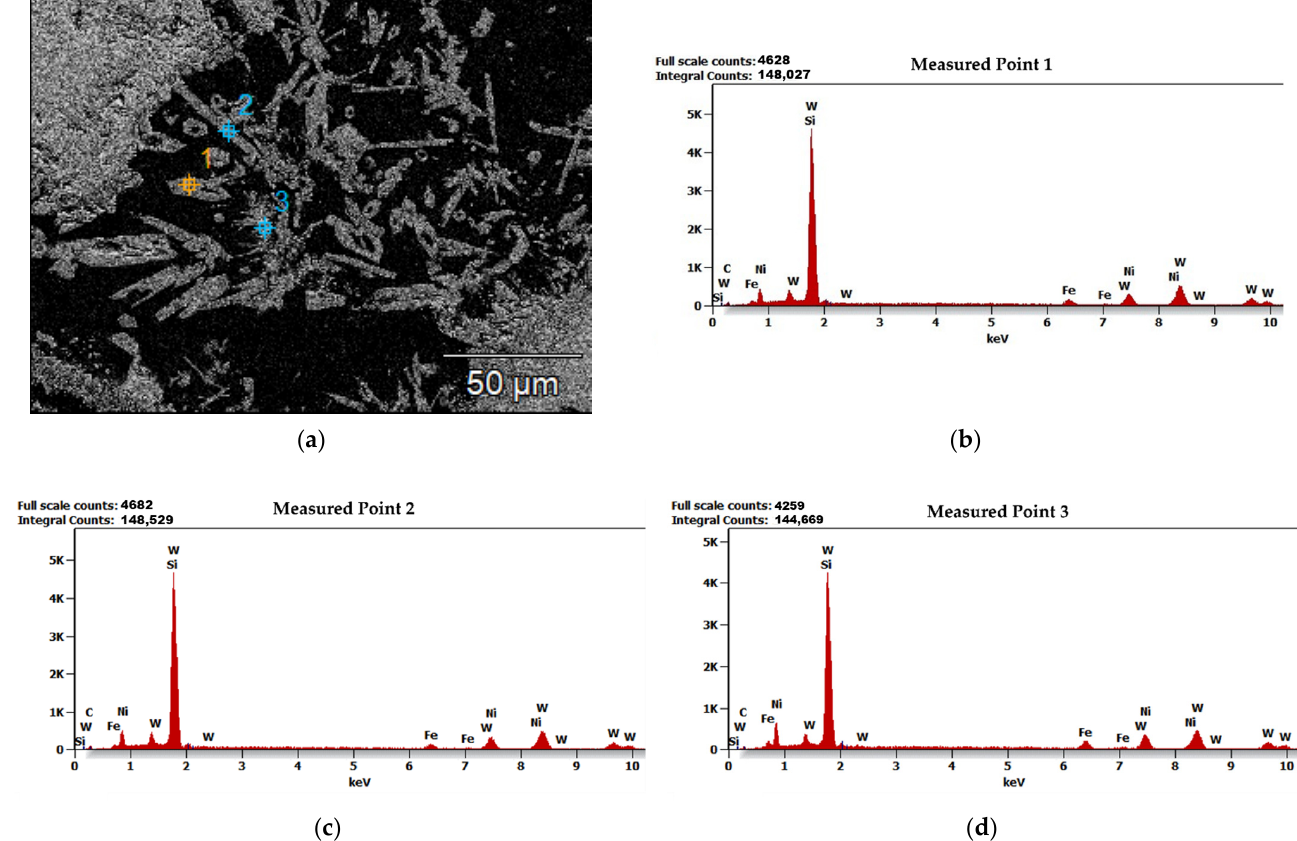
Figure 10. Results of microanalysis of precipitates of the WC reinforcement within the surface layer of sample 4-PE prepared under conditions of 110 A PTA current and 1.5L/min PGFR ( a ) Image of microanalytical area showing points of interests for analysis ( b – d ) Energy-dispersive X-ray spectrometry (EDS) diagrams of measured points 1 through 3.